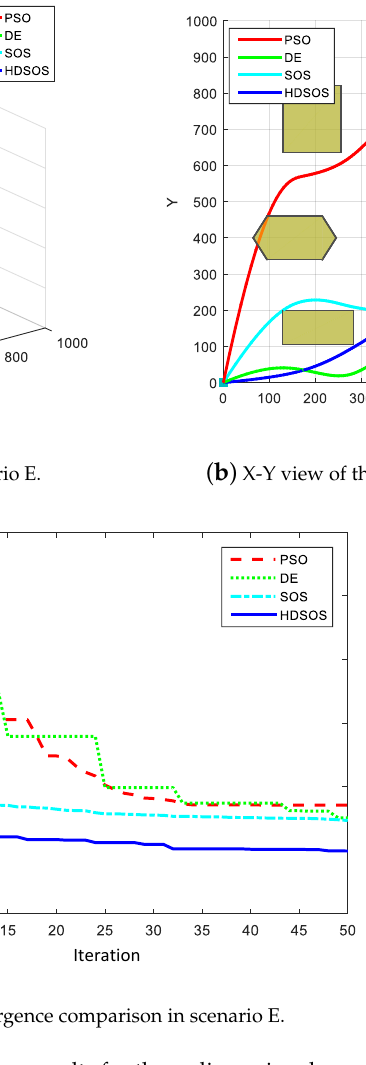
Figure 10. The comparative results for three-dimensional scenario